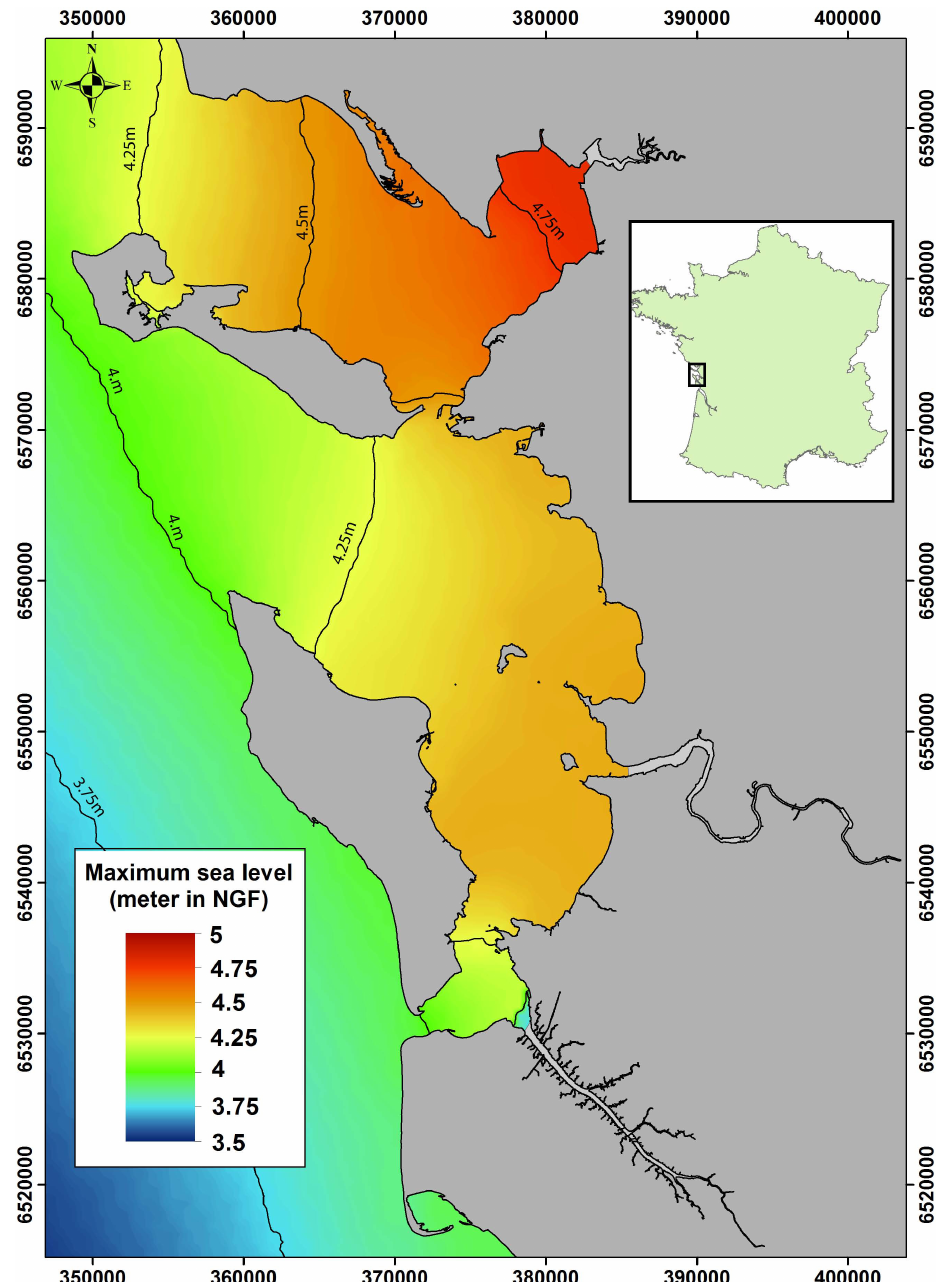
Fig. 3. Maximum sea level during the Xynthia storm in meter NGF calculated from the storm surge numerical model of Bertin et al.